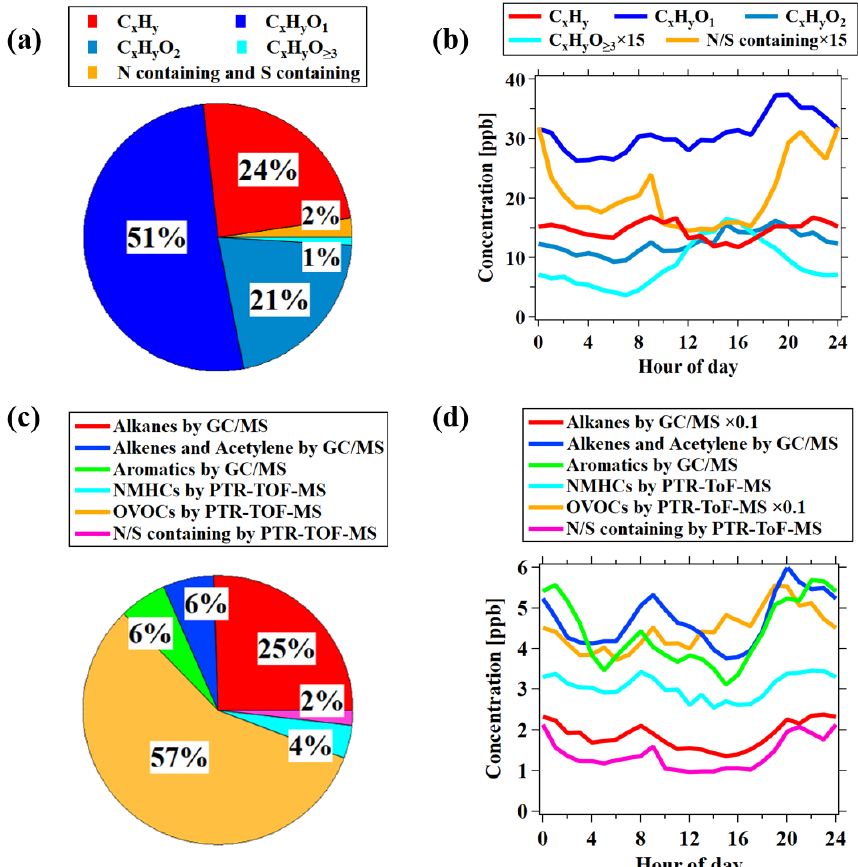
Figure 5. (a) The average concentration percentage of each category measured by PTR-ToF-MS during the campaign. The different ion categories shown in (a) and (b) are discussed in the text in detail. (b) Diurnal variations in each category measured by PTR-ToF-MS during the campaign. (c) The average concentration percentage of each category of VOCs during the observation period. Alkanes, alkenes and acetylene, and aromatics were measured by GC–MS/FID, while OVOCs and N/S -containing species were measured by PTR-ToF-MS. NMHCs measured by PTR-ToF-MS represents hydrocarbons measured by PTR-ToF-MS after removing overlapping species with GC– MS/FID (e.g., C 6 –C 9 aromatics and isoprene). (d) Diurnal variations in each category of VOCs shown in (c) during the